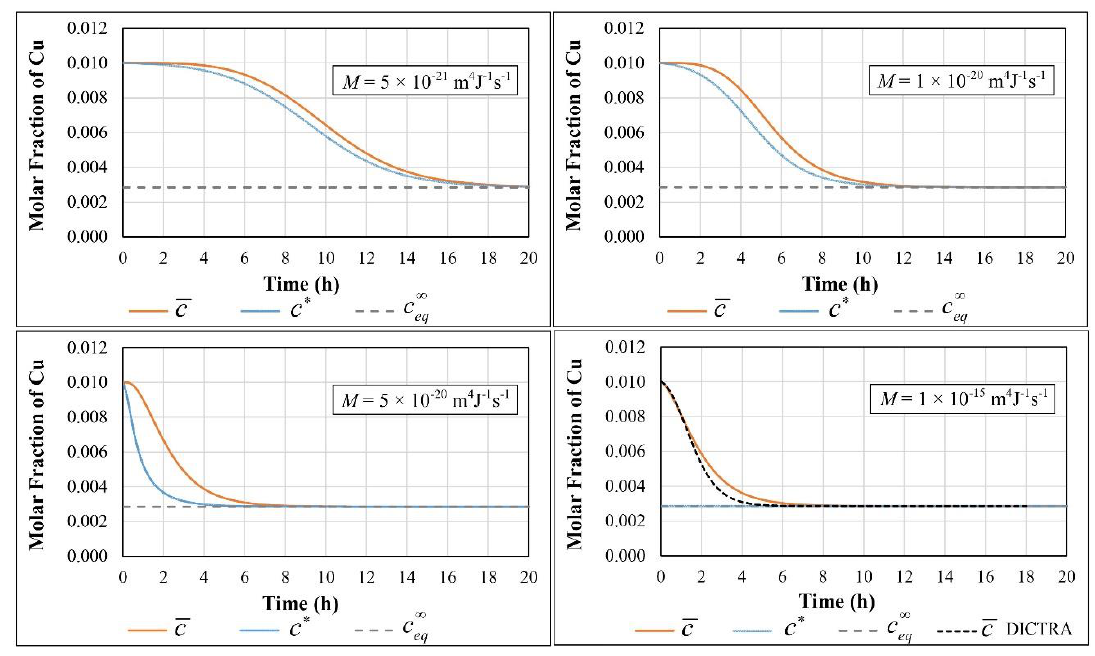
Figure 7. Evolution of c and c ∗ for a spherical θ -Al 2 Cu precipitate growing in a finite Al-1.0 at%Cu matrix with different values for the interfacial mobility.